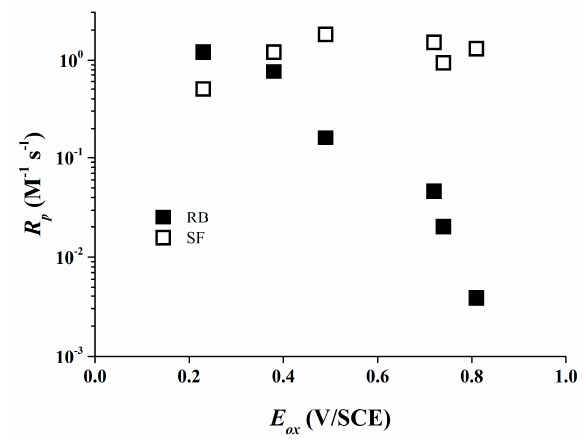
Figure 6. Rate of polymerization R p for Rose Bengal ( RB ) (filled symbols) and Safranine O ( SF ) (open symbols) versus the oxidation potential E ox of the borate salts [35].